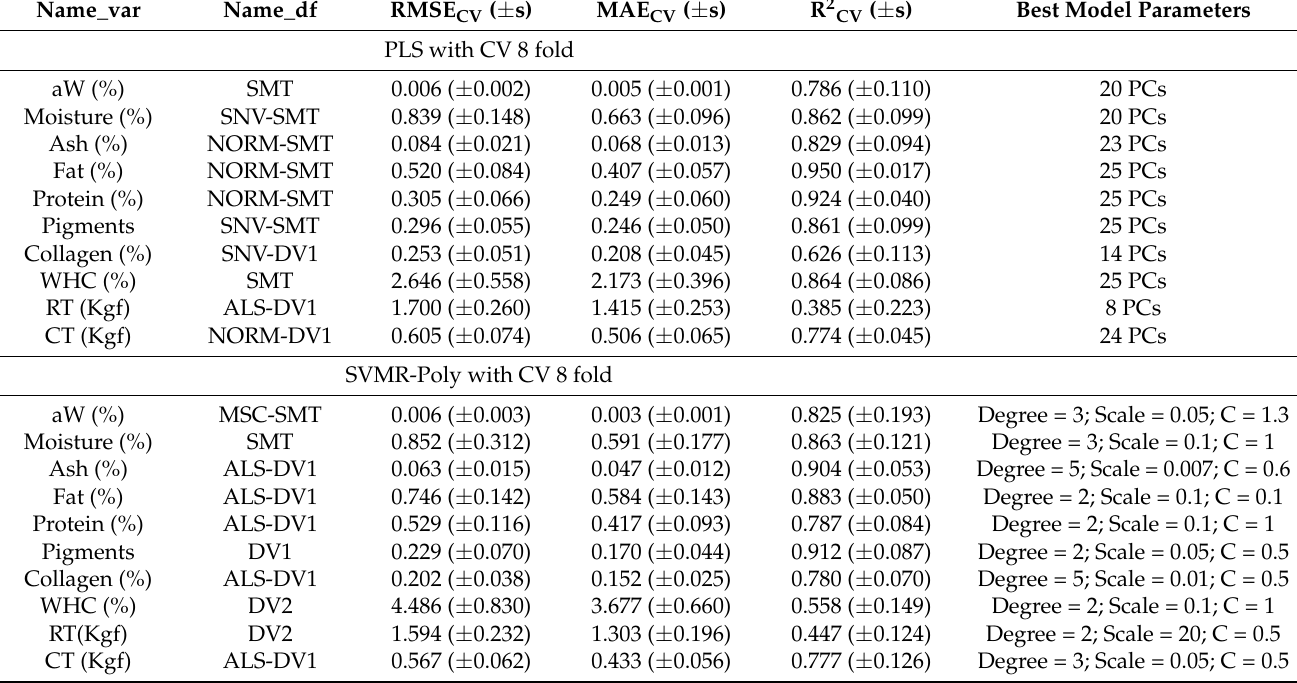
Table 2. Average cross-validation (8 folds) results for the selected PLS and SVMR-Poly